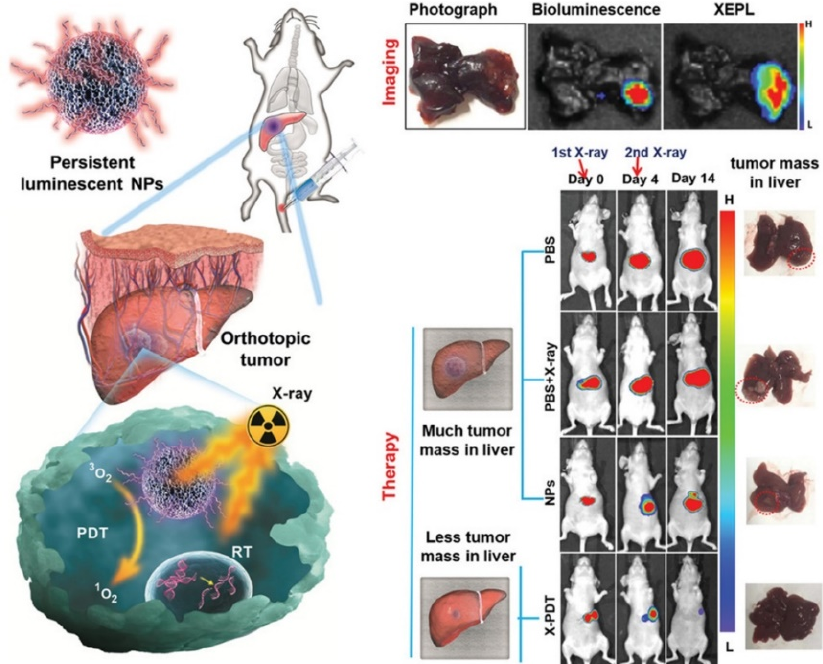
Figure 11. Schematic illustration of persistent luminescent nanocrystal-incorporated MSNs for afterglow luminescence imaging and photodynamic therapy in vivo. The as-synthesised nanoparticles are composed of the mesoporous silica-templated zinc gallogermanate (mZGGOs) nanocomposite core, an outer PEGylated coating and the loading of silicon phthalocyanine photosensitiser (Si-Pc). This design exhibited rechargeable X-ray-excited persistent luminescence (XEPL) properties for bioimaging and the ability of tumour suppression. Reprinted with permission from reference [139]. Copyright (2020) Wiley-VCH.